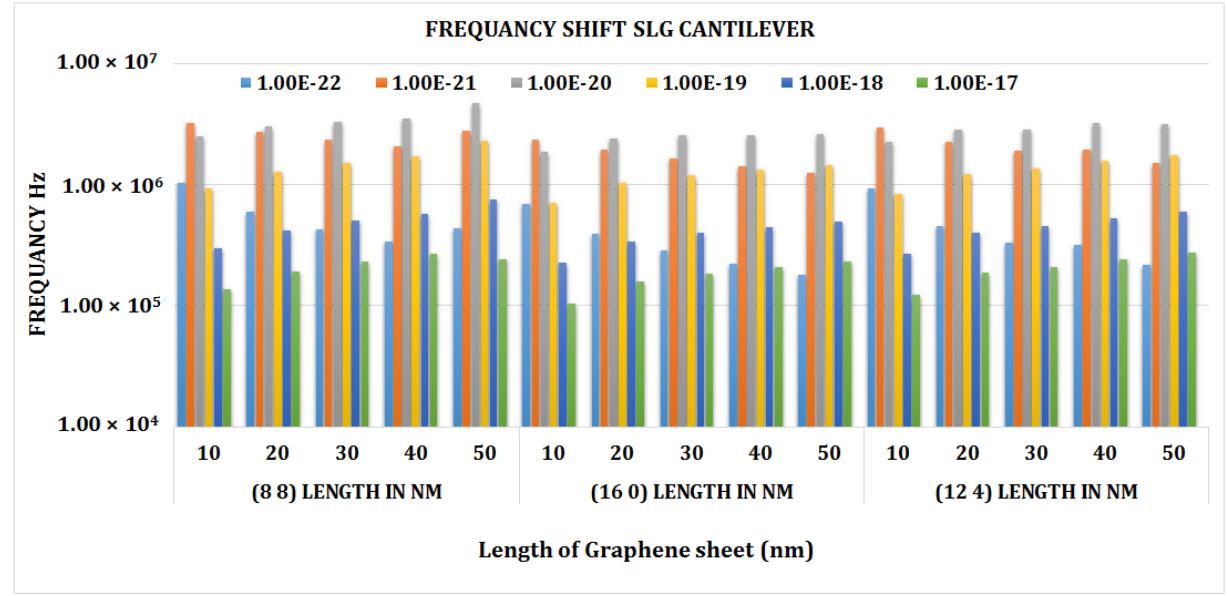
Figure 10. Frequency shift vs. length of graphene sheet for chiral, armchair, and zigzag cantilever SLG.